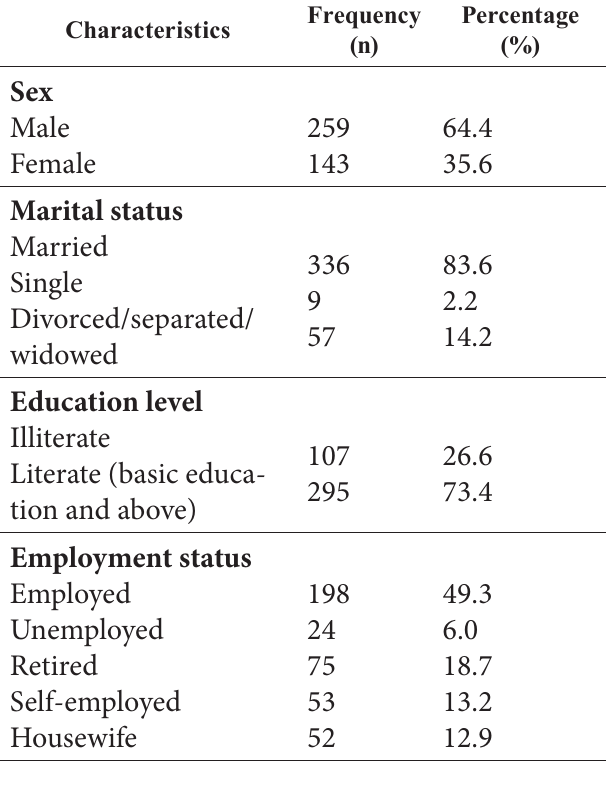
TABLE I - S ummary of the demographics of respondents (n = 402) Characteristics